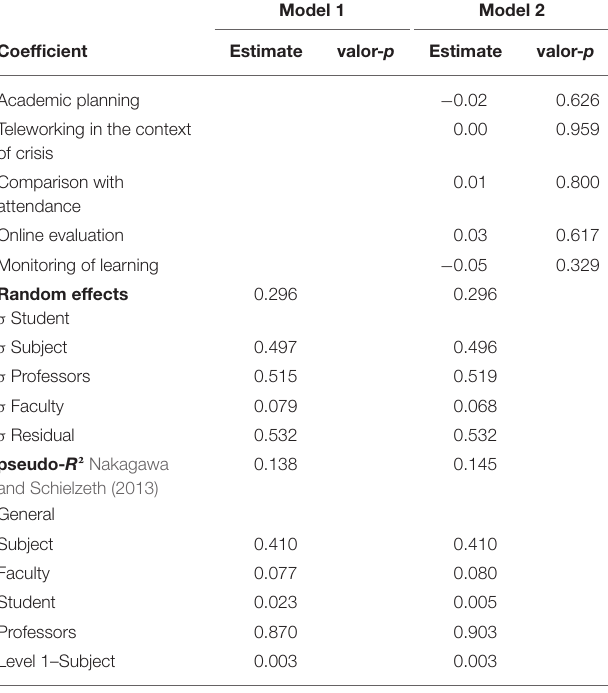
TABLE 5 | Model 1, 2 and 3 adjustment coefficients and